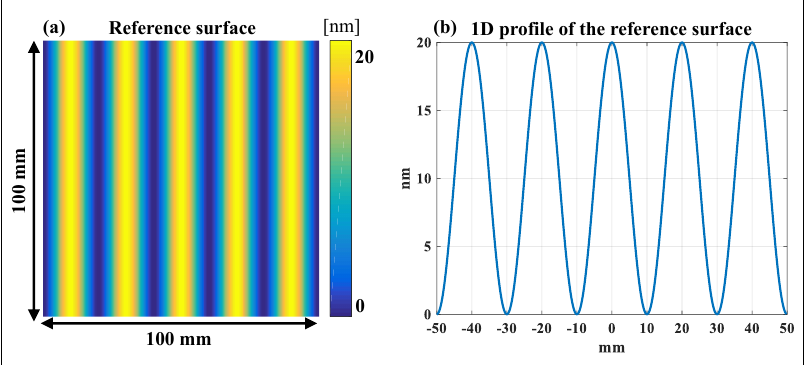
Figure 3. ( a ) The reference surface error map and ( b ) its 1D profile along the x